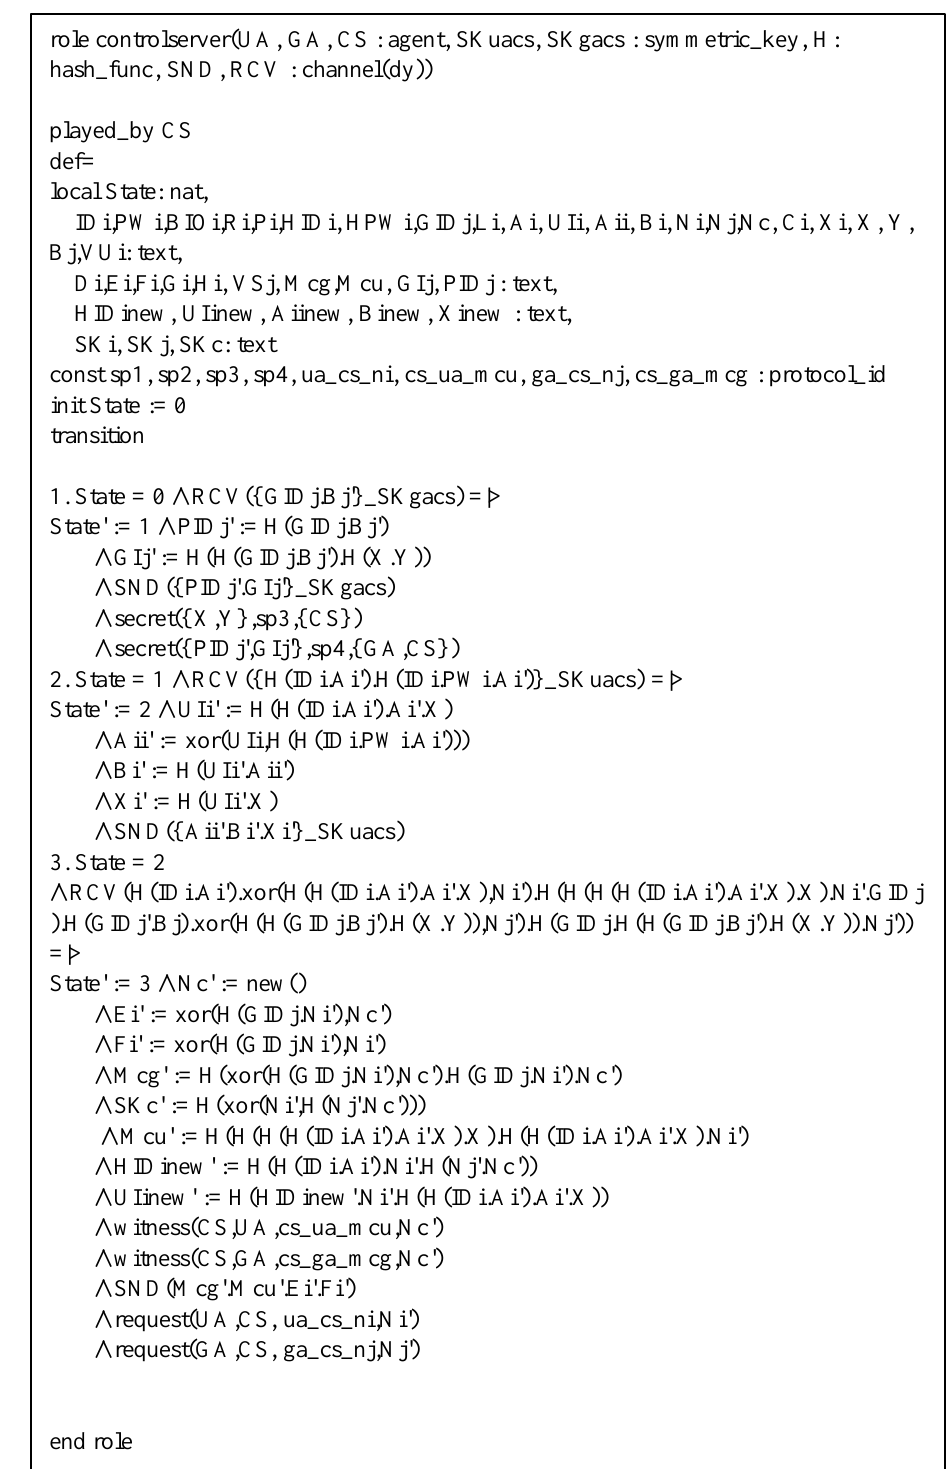
Figure 11. Specification of control